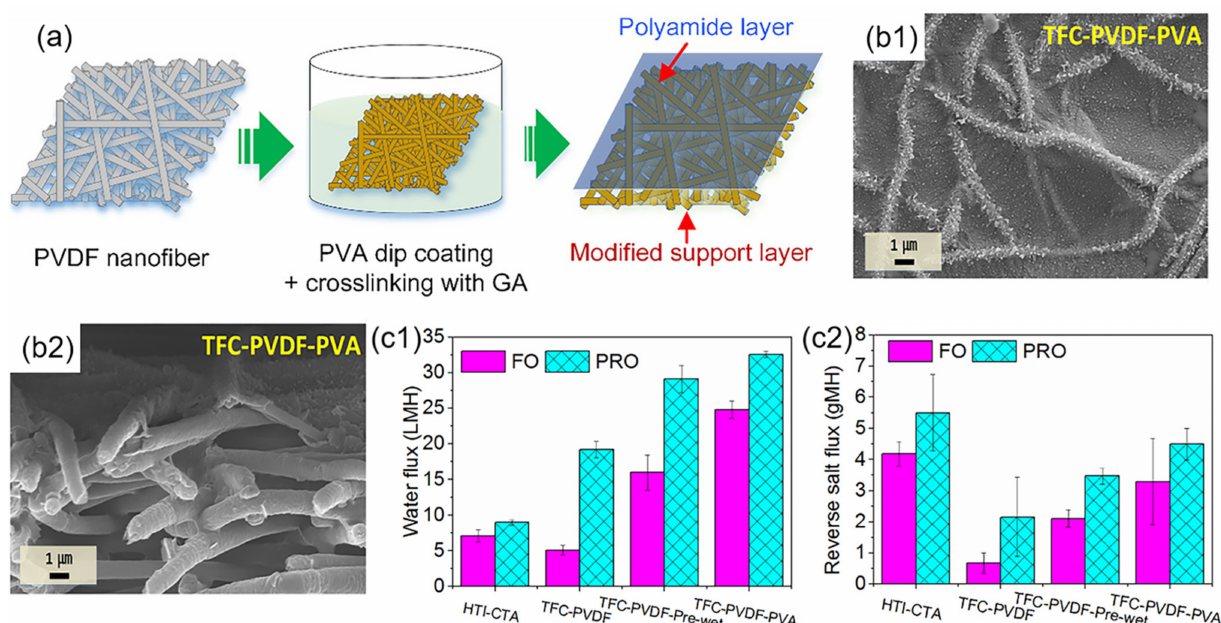
Figure 10. ( a ) Schematic diagram of TFN C PVDF/PVA ENMs; ( b ) FESEM images of PVDF/PVA nanofiber layer and TFNC PVDF/PVA ENMs for top surface ( b1 , b2 ); ( c ) FO performance of com- mercial HTI-CTA ( c1 ) and prepared TFNC PVDF/PVA ENMs ( c2 ). Reprinted with permission from Ref. [148]. 2017,